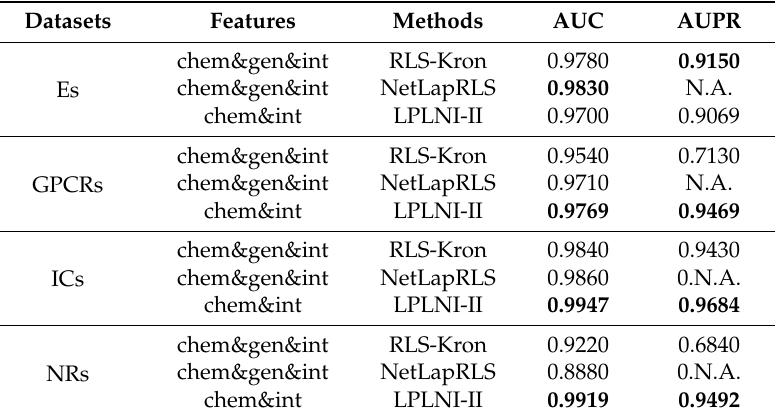
Table 3. Performances of LPLNI-II and other state-of-the-art